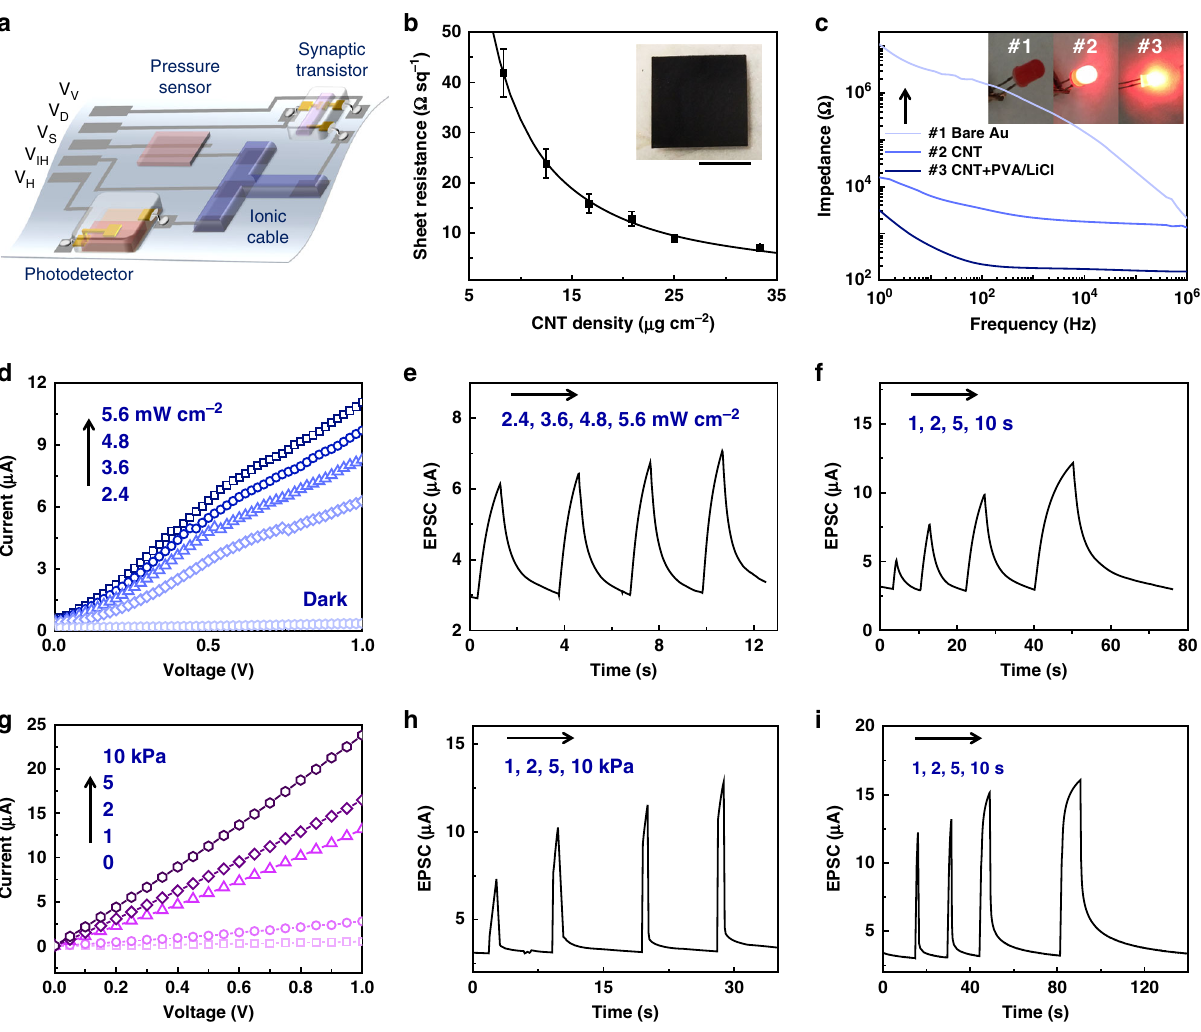
Fig. 2 Characteristics of visual and haptic sensory channel illustrating the bimodal sensing capability. a The schematic diagram of the BASE for visual- haptic fusion (the sensors are encapsulated by PDMS). b The sheet resistance of the CNT electrodes with different density. Inset: the digital image of the test sample with density of 25 μ g cm − 2 . The error bars are the standard deviations. The scale bar is 1 cm. c The impedance of the PVA hydrogel rod contacted with different electrodes. Inset: the LED connected to different electrodes that are connected with the PVA hydrogel. The drive voltage is 3.0 V with a frequency of 1 kHz. Visual sensory channel characterizations: d IV characterizations; e the EPSC responses to four different intensities (duration: 1 s); f the EPSC responses to four different durations (intensity: 4.8 mWcm − 2 ). Haptic sensory channel characterizations: g IV characterizations; h the EPSC responses to four different intensities (duration: 1 s); i the EPSC responses to four different durations (intensity: 2